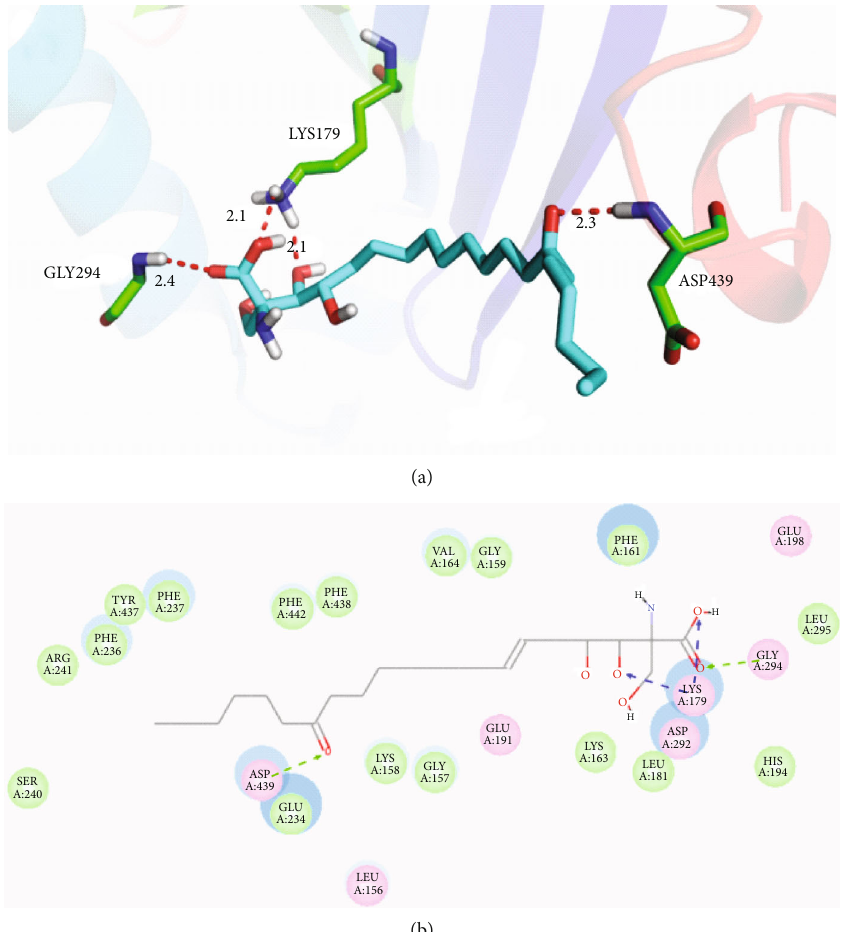
Figure 6: (a) Proposed binding mode of myriocin with AKT1 (PDB code: 3OCB). (b) 2D presentation of interaction between myriocin and